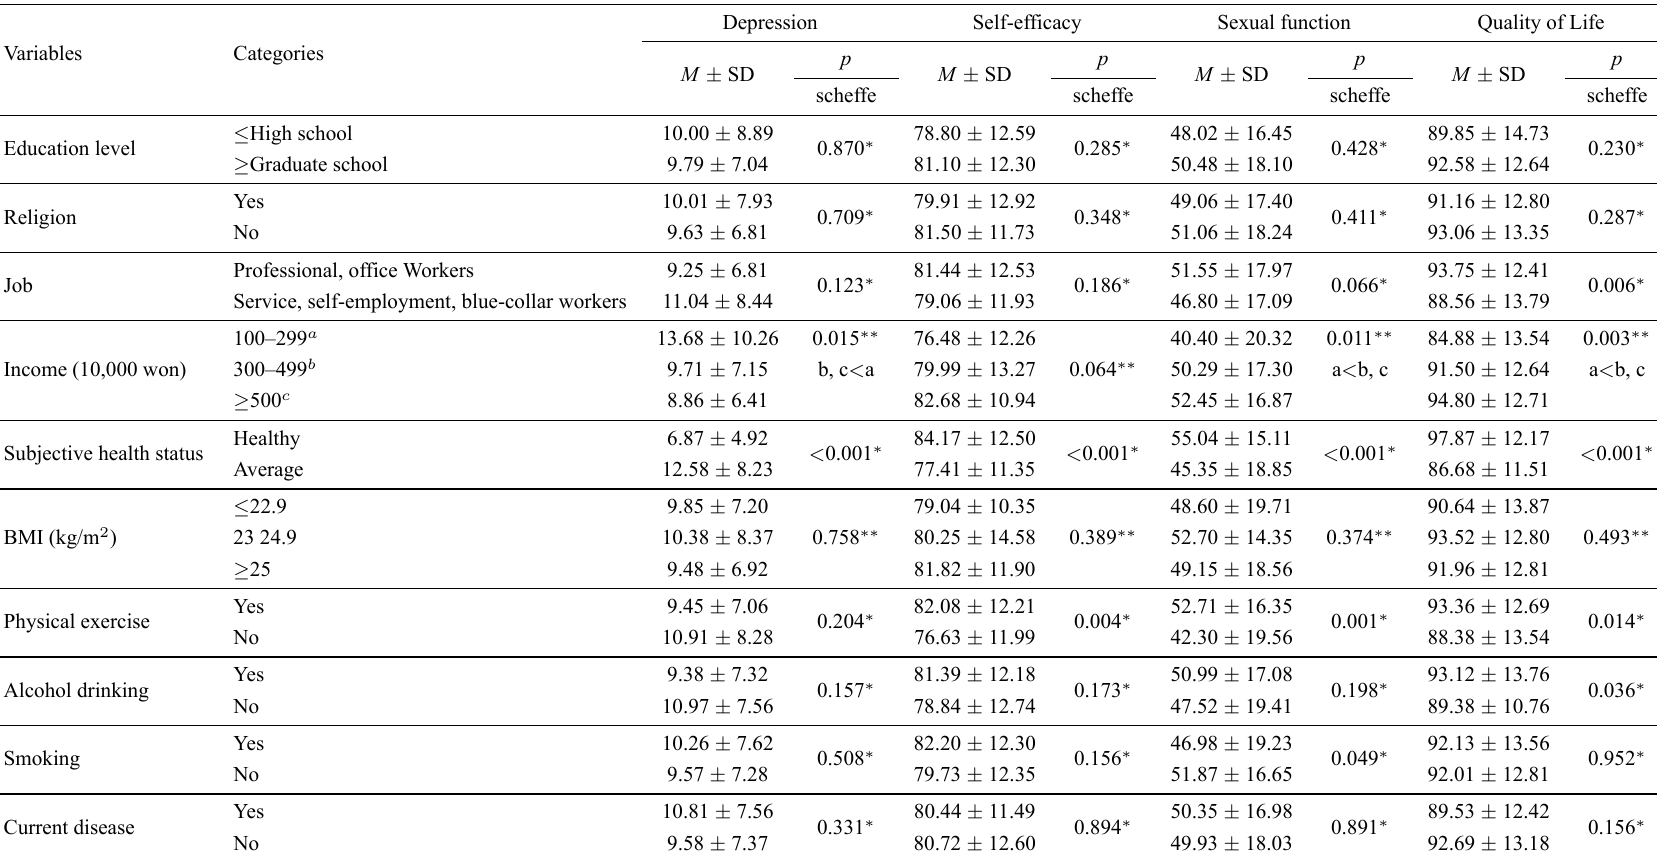
Table 2. Differences in depression, self-efficacy, sexual function, and quality of life according to general characteristics (N =